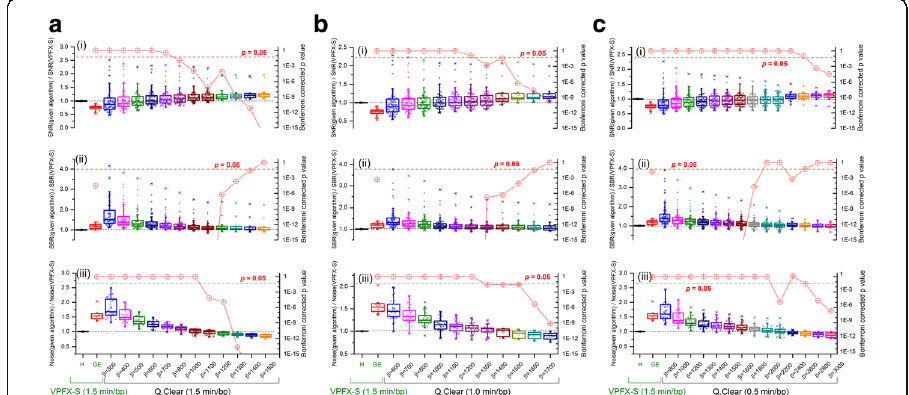
Fig. 3 Box plots of (i) SNR, (ii) SBR and (iii) noise level values calculated from studies reconstructed using Q.Clear with various β and a 1.5 min/bp, b 1.0 min/bp and c 0.5 min/bp and GE OSEM (1.5 min/bp), normalized to the values obtained using the Hadassah OSEM reconstruction algorithm with 1.5 min/bp (left Y -axis). The upper and lower part of the box represent the upper and lower quartile, respectively. The line and the square in the box stand for the median and the mean values, respectively. The Bonferroni corrected p values for a given algorithm compared to Hadassah OSEM are shown in red circles (right Y